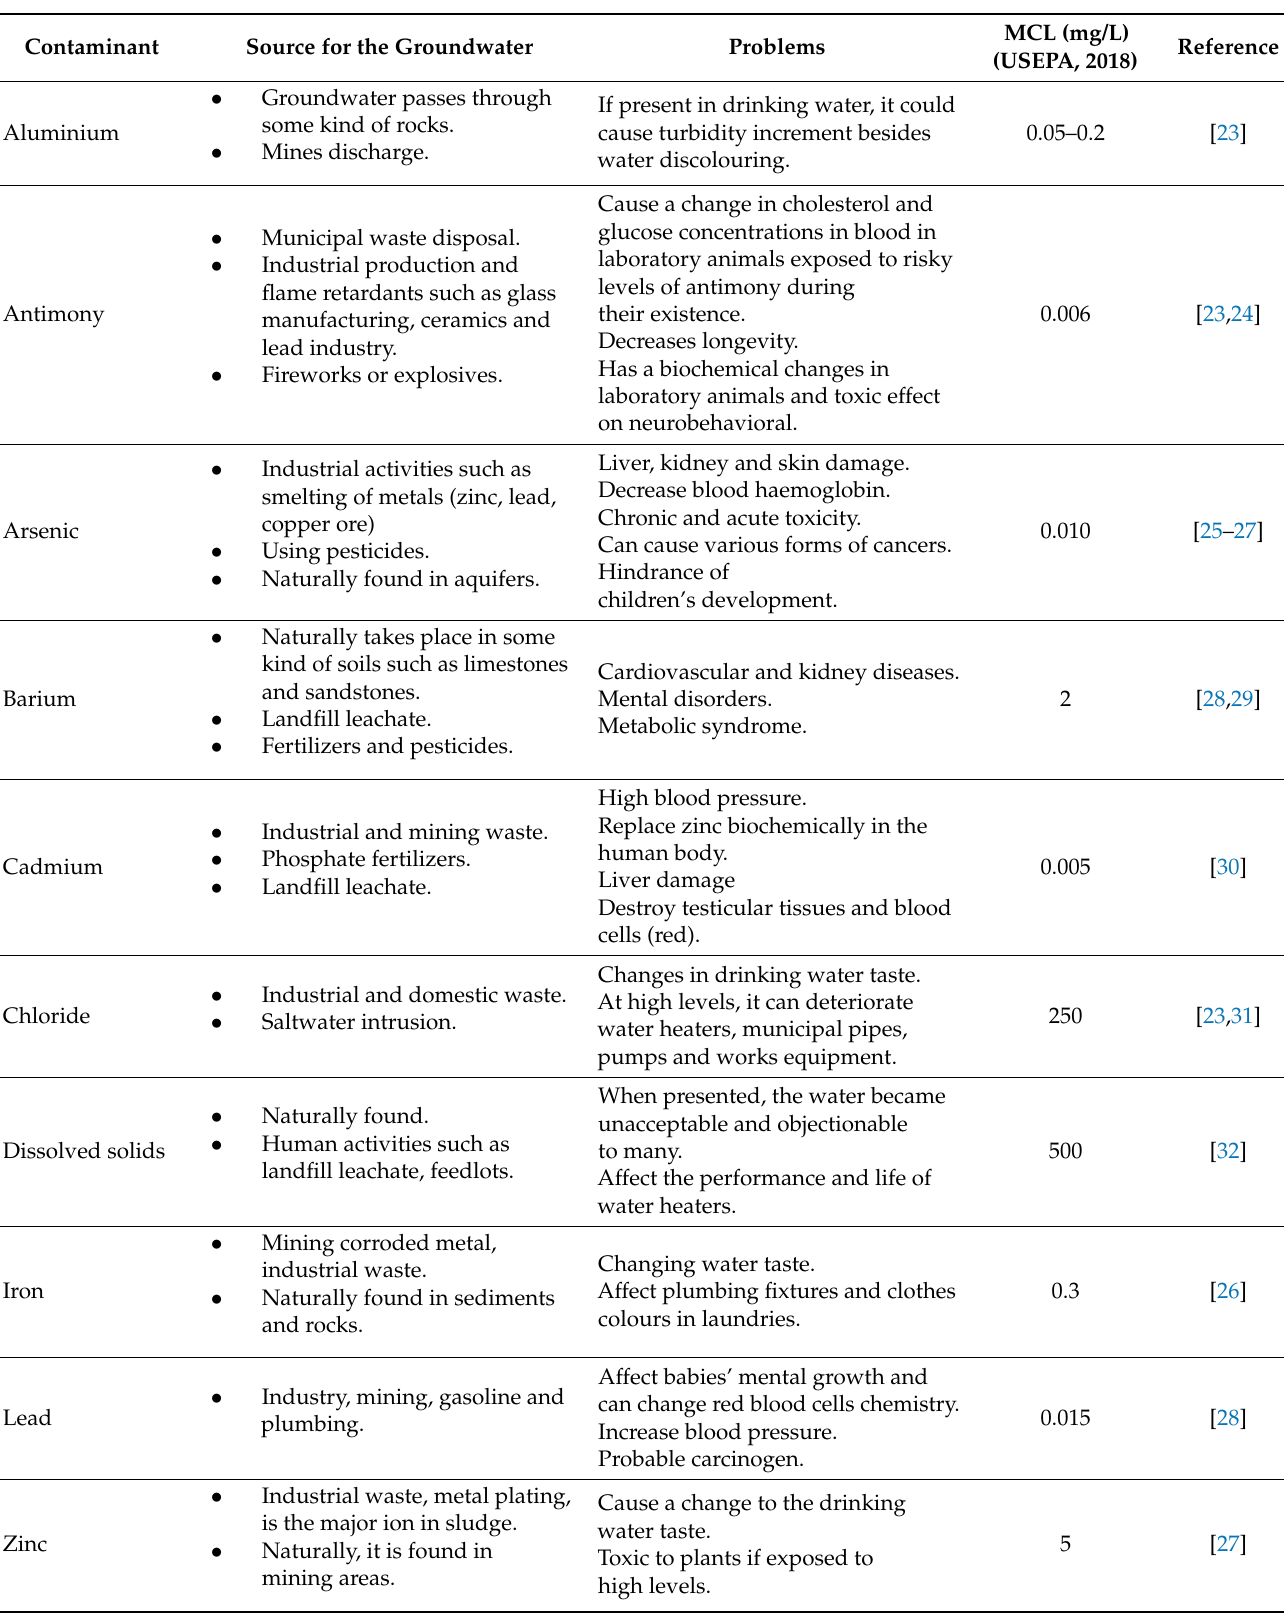
Table 1. Inorganic pollutants presented in